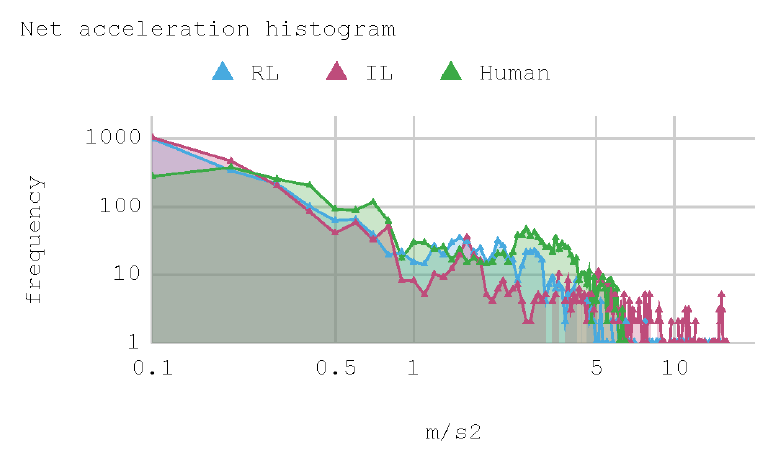
Figure 12. Case 1. Net acceleration histogram for training track. Table 10. Case 1. Mean speed and statistics derived from acceleration of IAs and human expert on the training track.